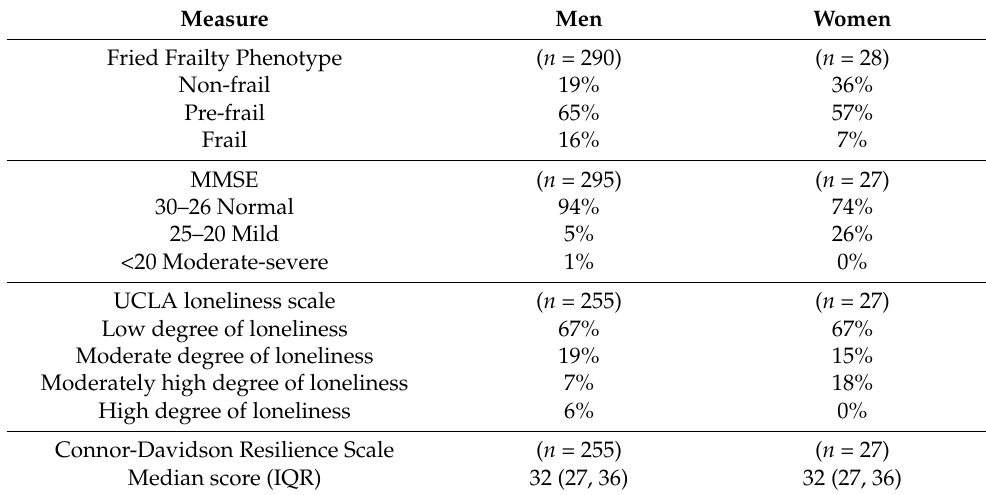
Table 3. Baseline frailty, cognitive function, loneliness, and resilience scores among participants enrolled in the CHANGE HIV cohort, according to gender. Measure Men Women Fried Frailty Phenotype ( n = 290) ( n =